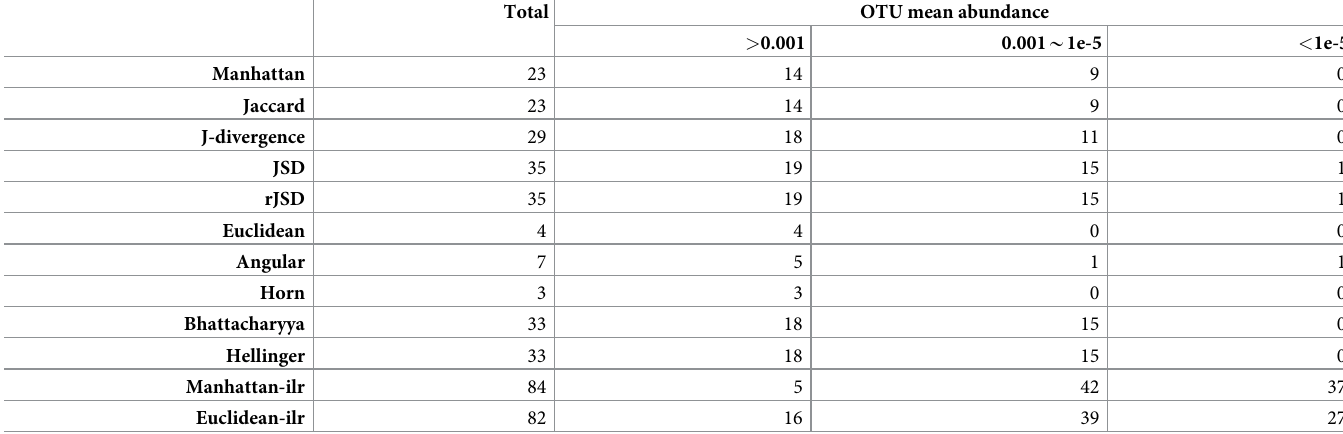
Table 2. Numbers of OTUs whose adjusted p-values with FDR control are smaller than 0.05, and their frequencies at different abundance